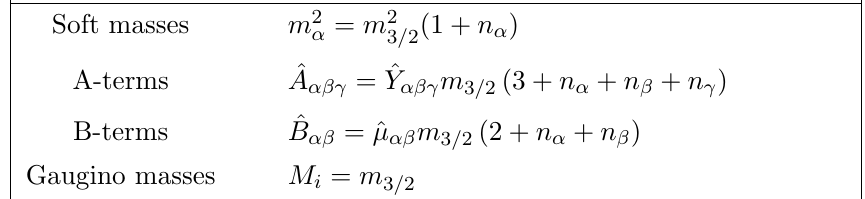
Table 3 . Summary of the soft terms in CSD vacua represented by the constraints (4.36). A coe(cid:14)cient n (cid:11) represents the modular weight (degree of the complex structure moduli in the K(cid:127)ahler metrics) for the open string excitation O (cid:11)